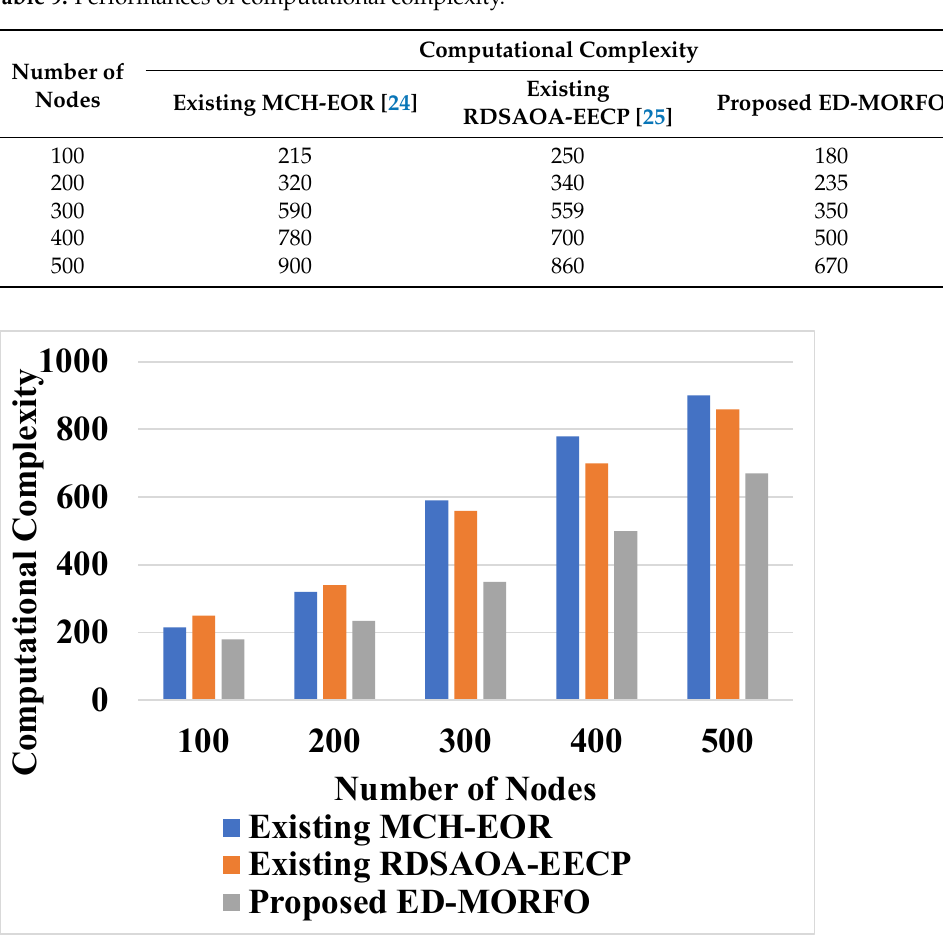
Figure 10. Performance of computational complexity for proposed EDMORFO and Existing MCH- EOR (Mehta, and Saxena, 2020), RDSAOA-EECP (Rajeswarappa, and Vasundra, 2021).